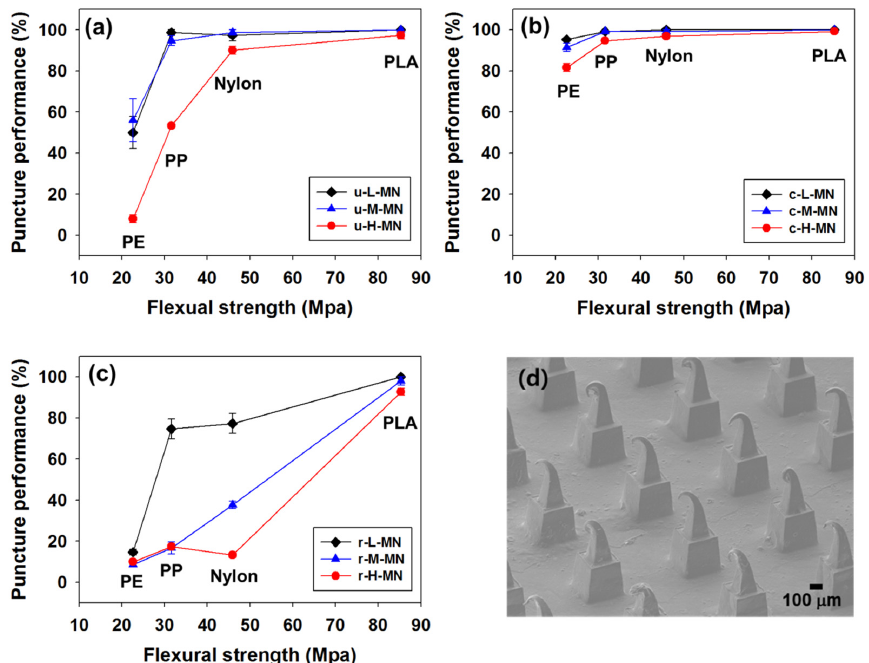
Figure 2. Puncture performance of ( a ) u-MNs, ( b ) c-MNs, ( c ) r-MNs MNs according to the mechanical strength of the polymer (polyethylene (PE), polypropylene (PP), nylon and polylactic acid (PLA)) and the aspect ratio of the MNs, ( d ) scanning electron microscope image of r-H-N MNs with bent tips. Flexural strengths of PE, PP, nylon and PLA are 22, 31, 45 and 85 MPa, respectively.